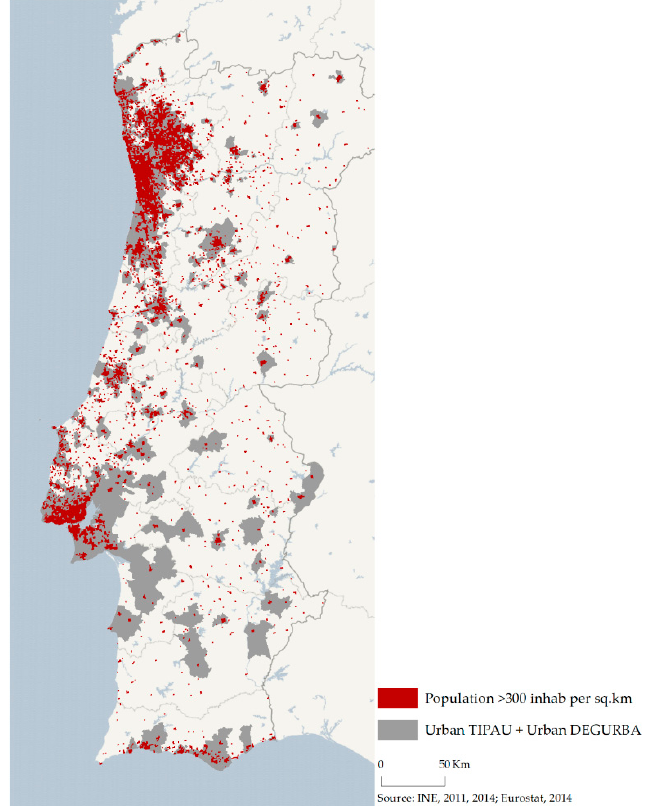
Figure 13. 1 sq.km population density in the GEOSTAT 2011 Grid, and urban areas according to TIPAU (APU) and DEGURBA (Code 1 and 2).